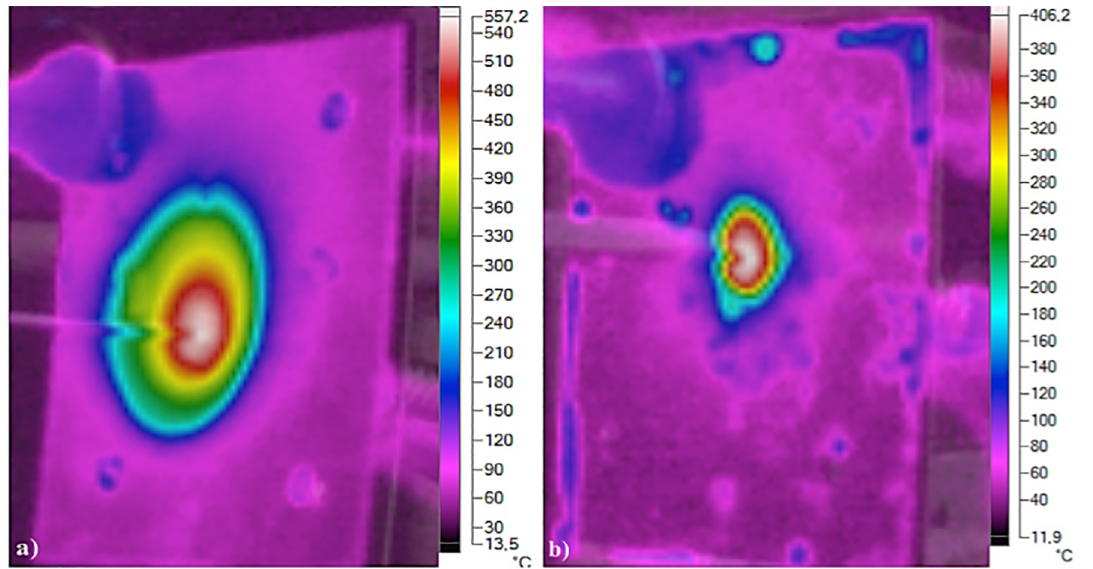
Figure 3. Temperature distribution on coated sample after 30 min of blowtorch application: a) blank and b) epoxy resin.